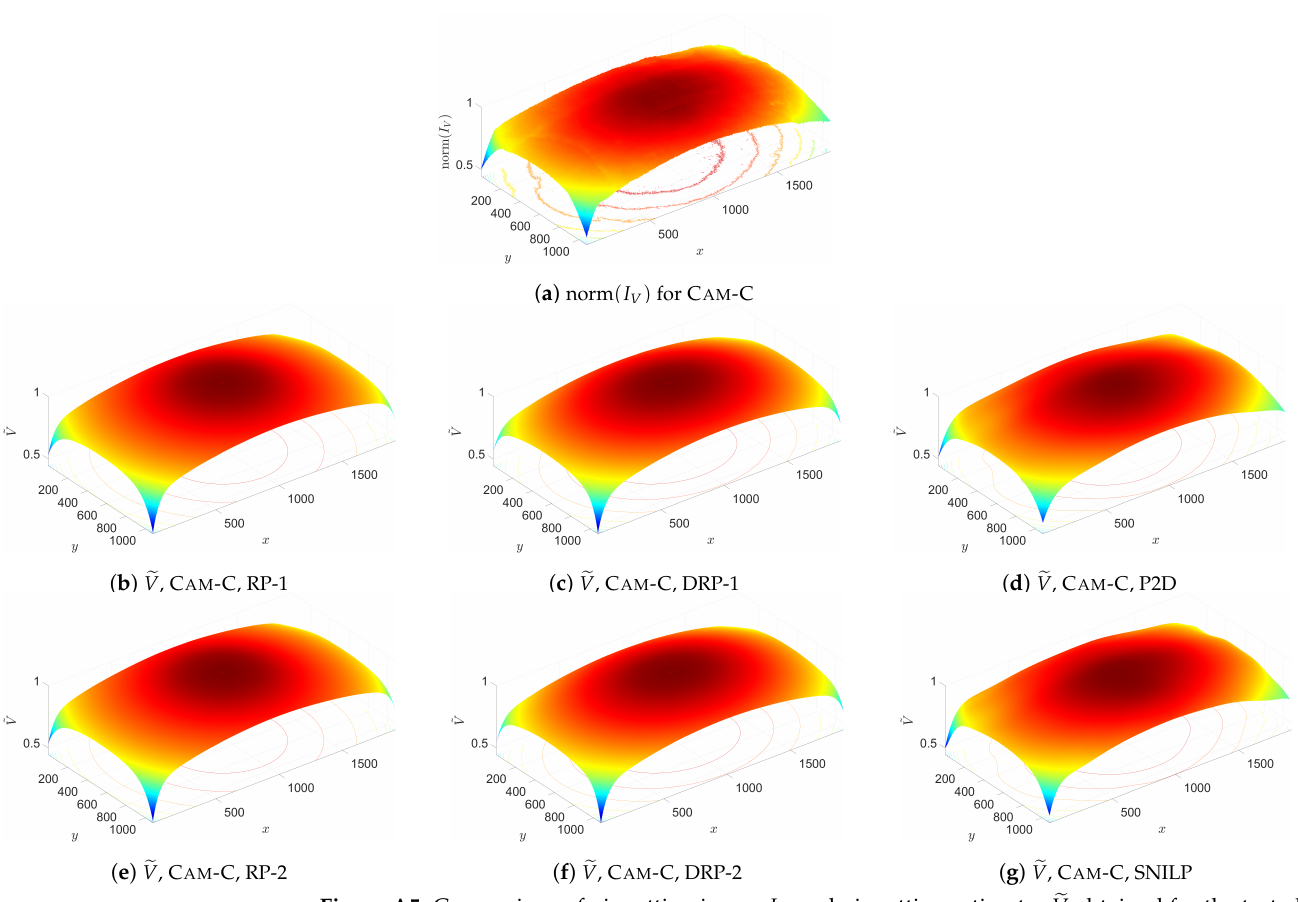
Figure A5. Comparison of vignetting image I V and vignetting estimates (cid:101) V obtained for the tested models and C AM -C.